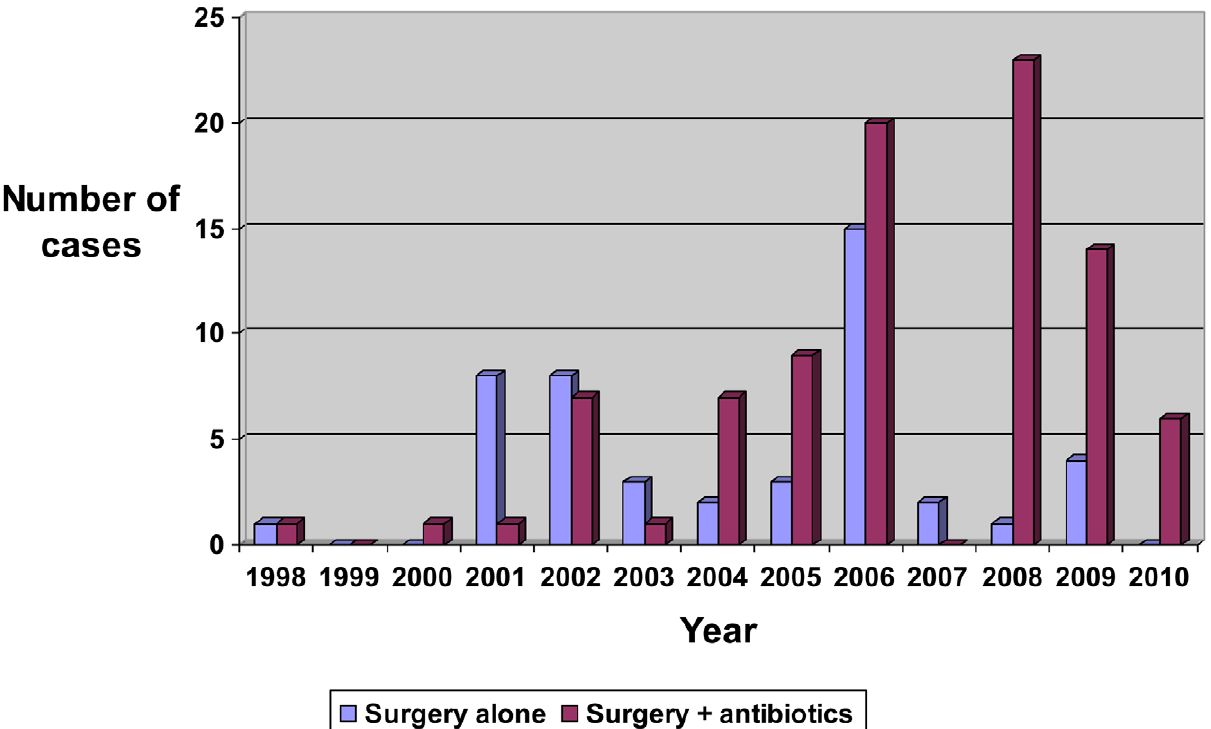
Figure 1. Type of treatment for initial M.ulcerans lesions.